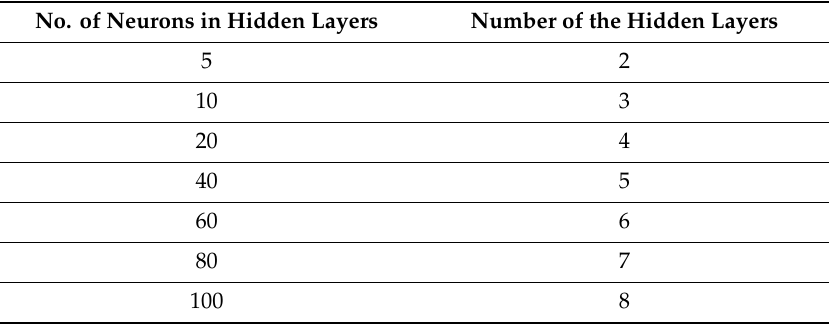
Table 5. The size of the hidden